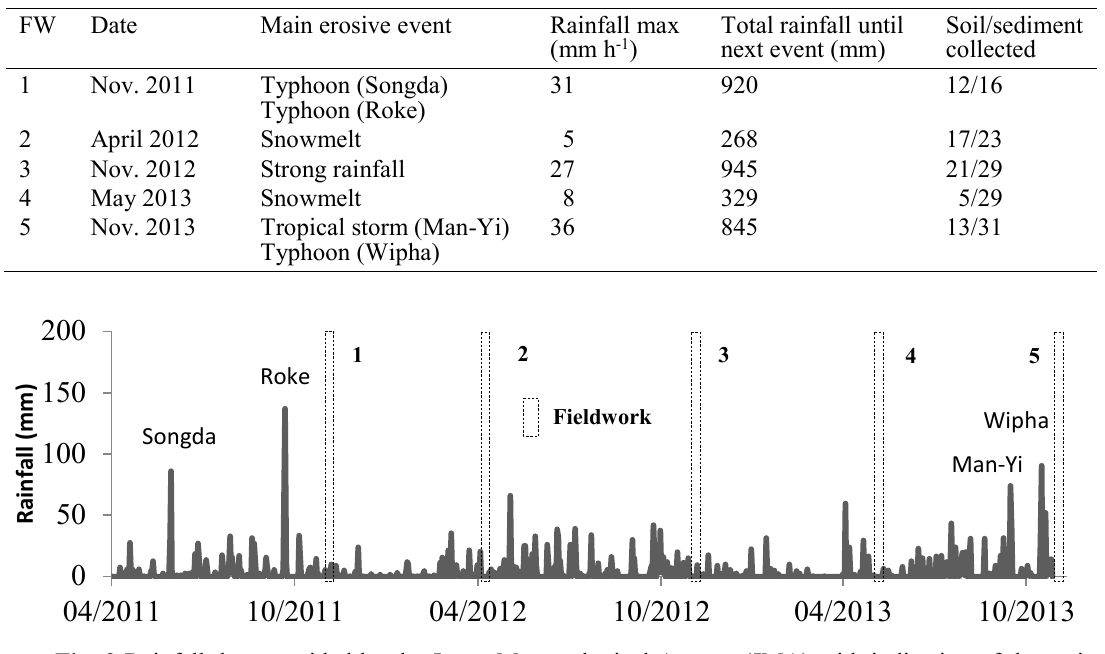
Fig. 2 Rainfall data provided by the Japan Meteorological Agency (JMA) with indication of the main rainfall events and the organization of fieldwork